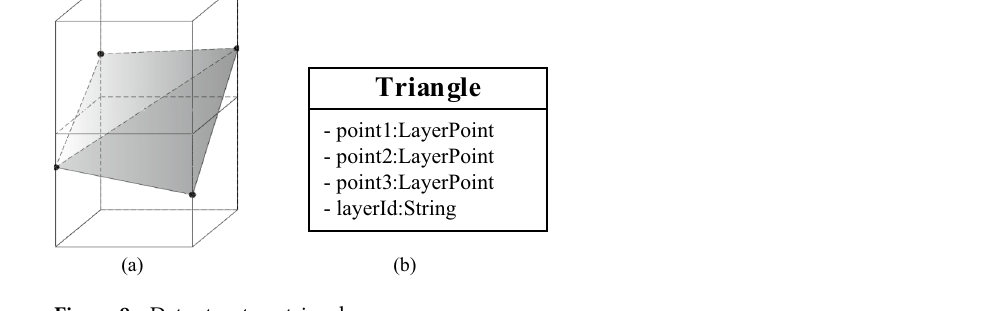
Figure 8. Data structure-triangle.